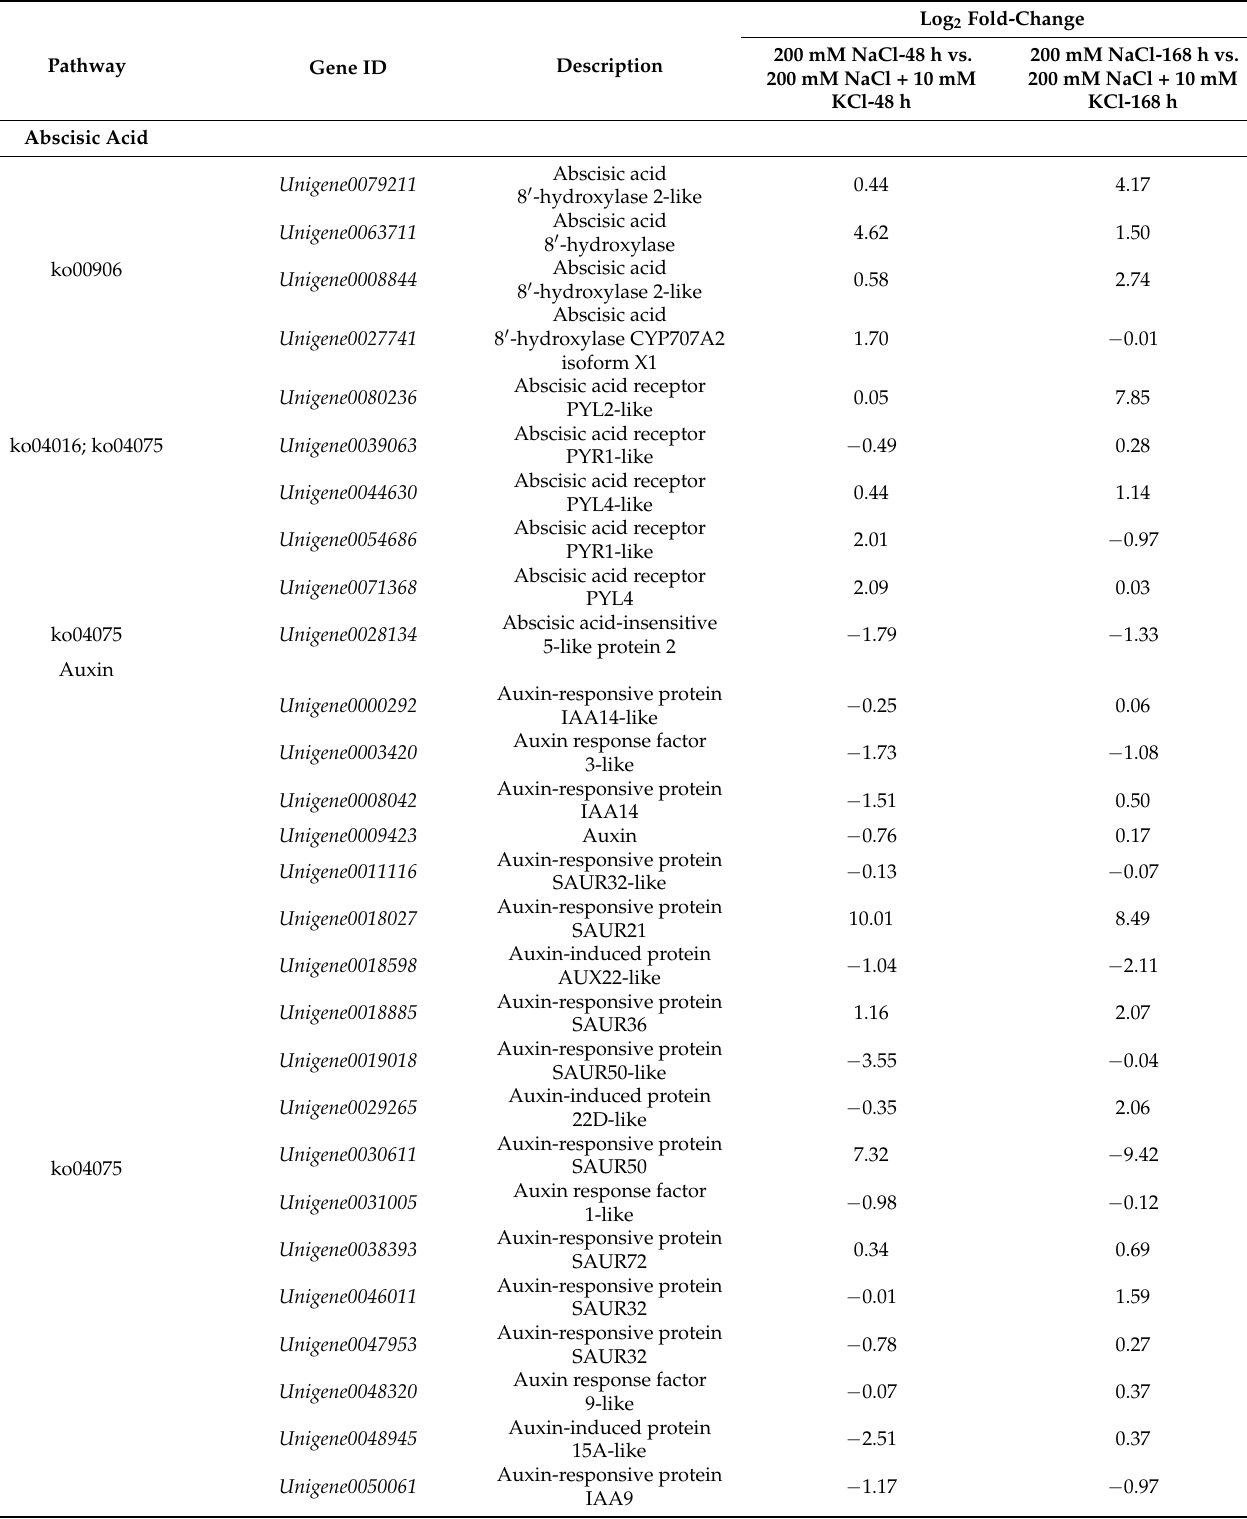
Table 2. Plant hormone candidate gene for exogenous potassium application in T. ramosissima roots under NaCl